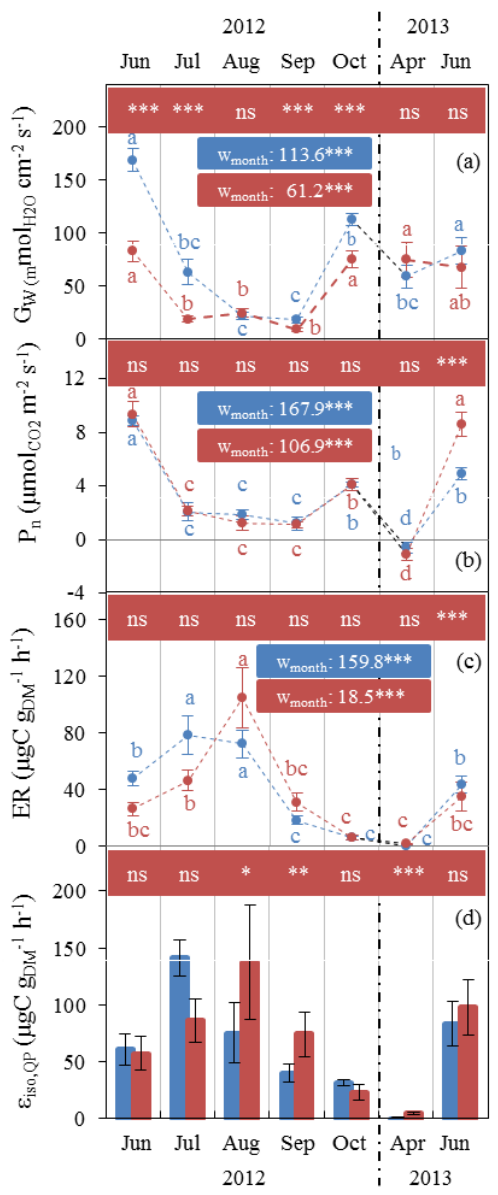
Figure 2. Seasonal variations of monthly Q. pubescens gas ex- changes observed at O 3 HP (June 2012 to June 2013) under ND (blue) and AD (red) (mean ± SD). (a) Stomatal conductance to wa- ter vapour G w . (b) Net photosynthetic assimilation P n . ( c ) Mea- sured branch isoprene emission rate ER. (d) Isoprene emission fac- tor ( I s ) calculated according to Guenther et al. (1995) using in situ ER vs. C L × C T correlations, except in July where mean ER mea- sured under enclosure conditions close to 1000µmolm − 2 s − 1 and 30 ◦ C was used. Differences between ND and AD using Mann– Whitney U tests are denoted using lower case letters (a>b>c>d). Differences among water treatment stress using Kruskal–Wallis tests are denoted by asterisks (*: P <0.05; **: P <0.01; ***: P